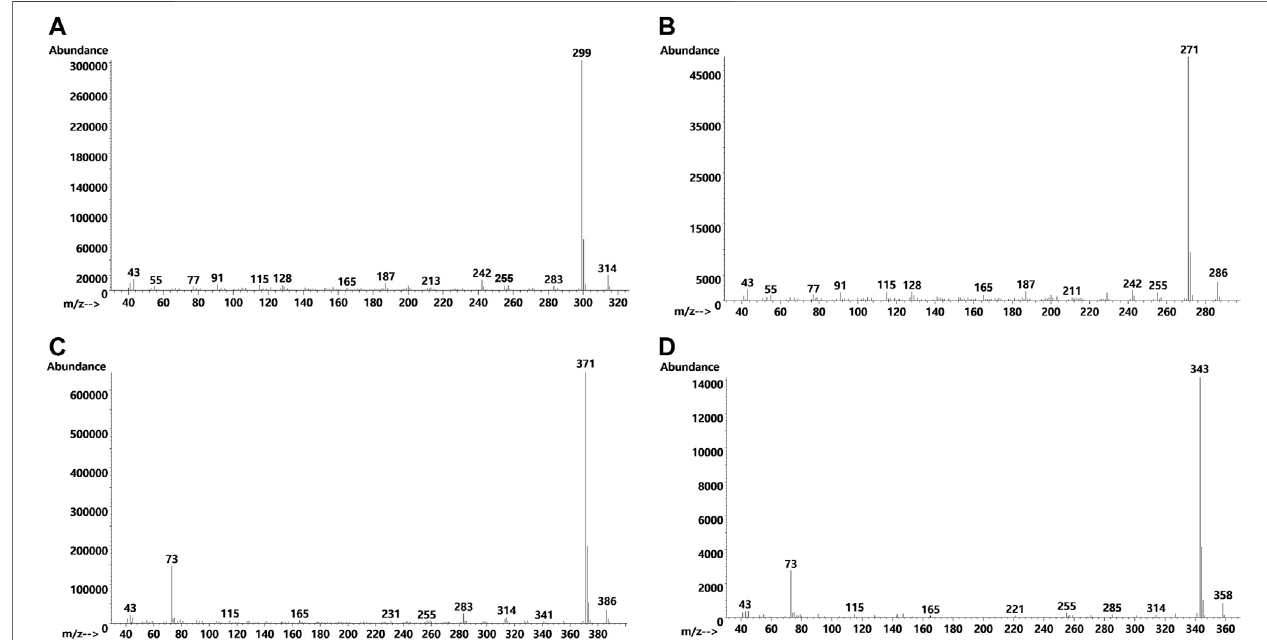
FIGURE 8 | Mass spectra for d6a, 10aTHC parent compound (A) and its monoTMS derivative (C) , and the analogous spectra for the d6a, 10aTHCV parent compound (B) and its monoTMS derivative (D) . The d6a, 10aTHC spectra were obtained from a standard, and the d6a, 10aTHCV spectra were obtained from vaping liquids (VL#12 – 14) in which d6a, 10aTHC was a predominant cannabinoid.